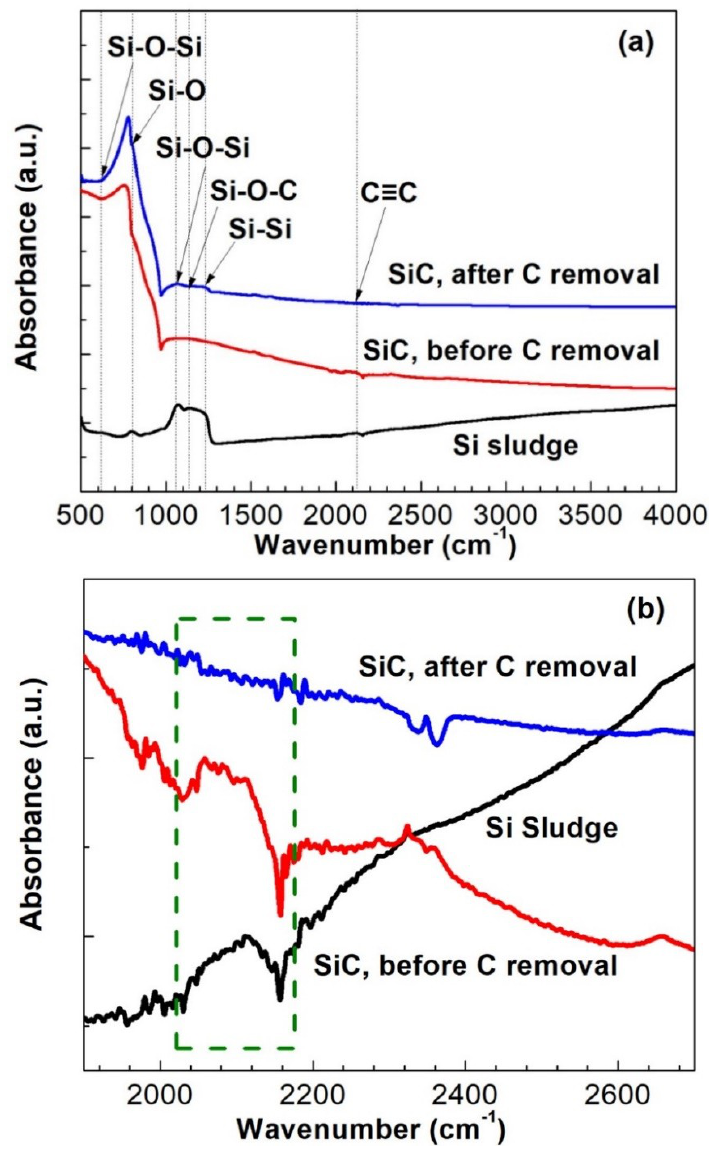
Figure 11. Comparison of attenuated total reflectance (ATR) profiles for Si sludge and SiC powder products before and after the carbon removal treatment, ( a ) normal scale, ( b ) enlarged profile around the C≡C peaks in ( a ).